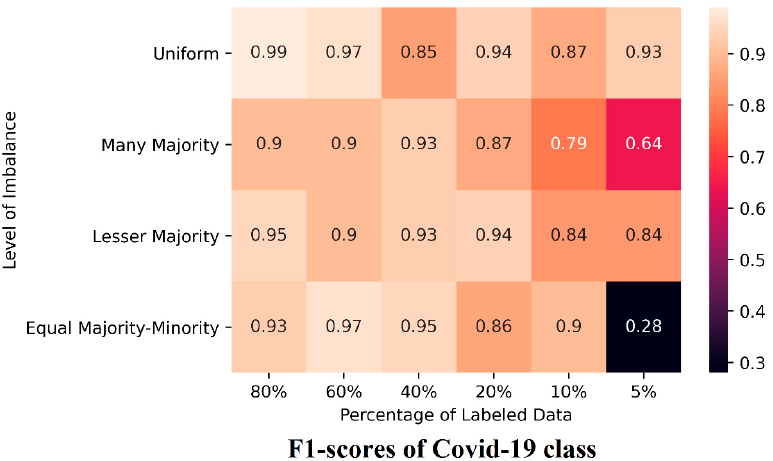
Figure 7. F1-scores of COVID-19 class for varied labeled samples and 4 levels of imbalance.